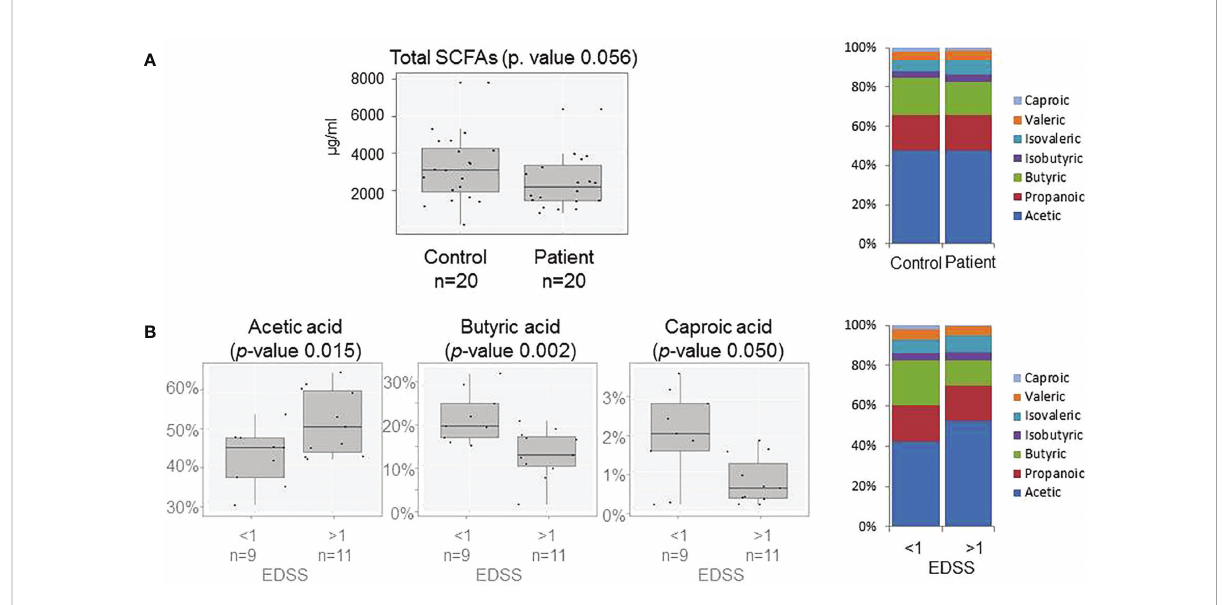
FIGURE 3 (A) Box plots showing abundance of total SCFAs in fecal samples (on the left) and SCFAs production (on the right) of patients and controls. (B) Box plots showing abundance of Acetic, Butyric and Caproic acids (on the left) and SCFAs pro fi le (on the right) of patients grouped by EDSS score (> ≤